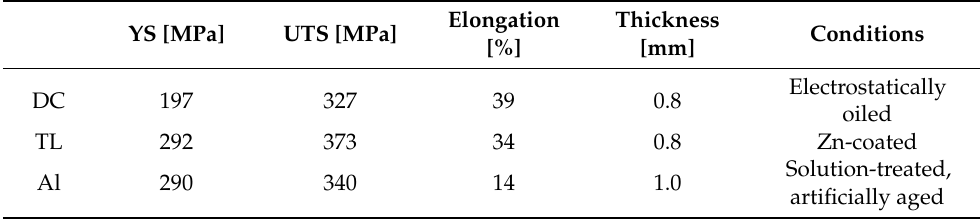
Table 1. Mechanical properties and some specific conditions of materials.